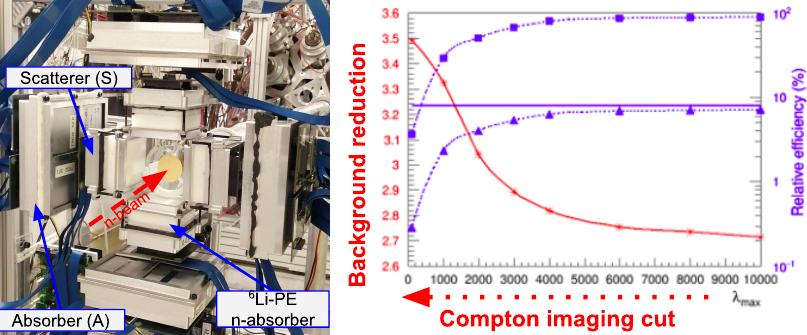
Figure 2. Left: Final i-TED array used in the recent 79 Se( n ,γ ) experiment at CERN n_TOF EAR1. Right: Background reduction factor at 10 keV and relative (n, γ ) e ffi ciency as a function of the Compton imaging cut (see text for